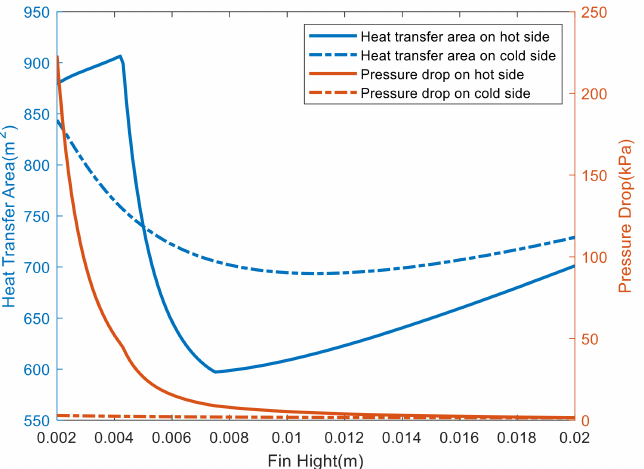
Figure 9. Effect of fin height on heat transfer area and pressure drop of